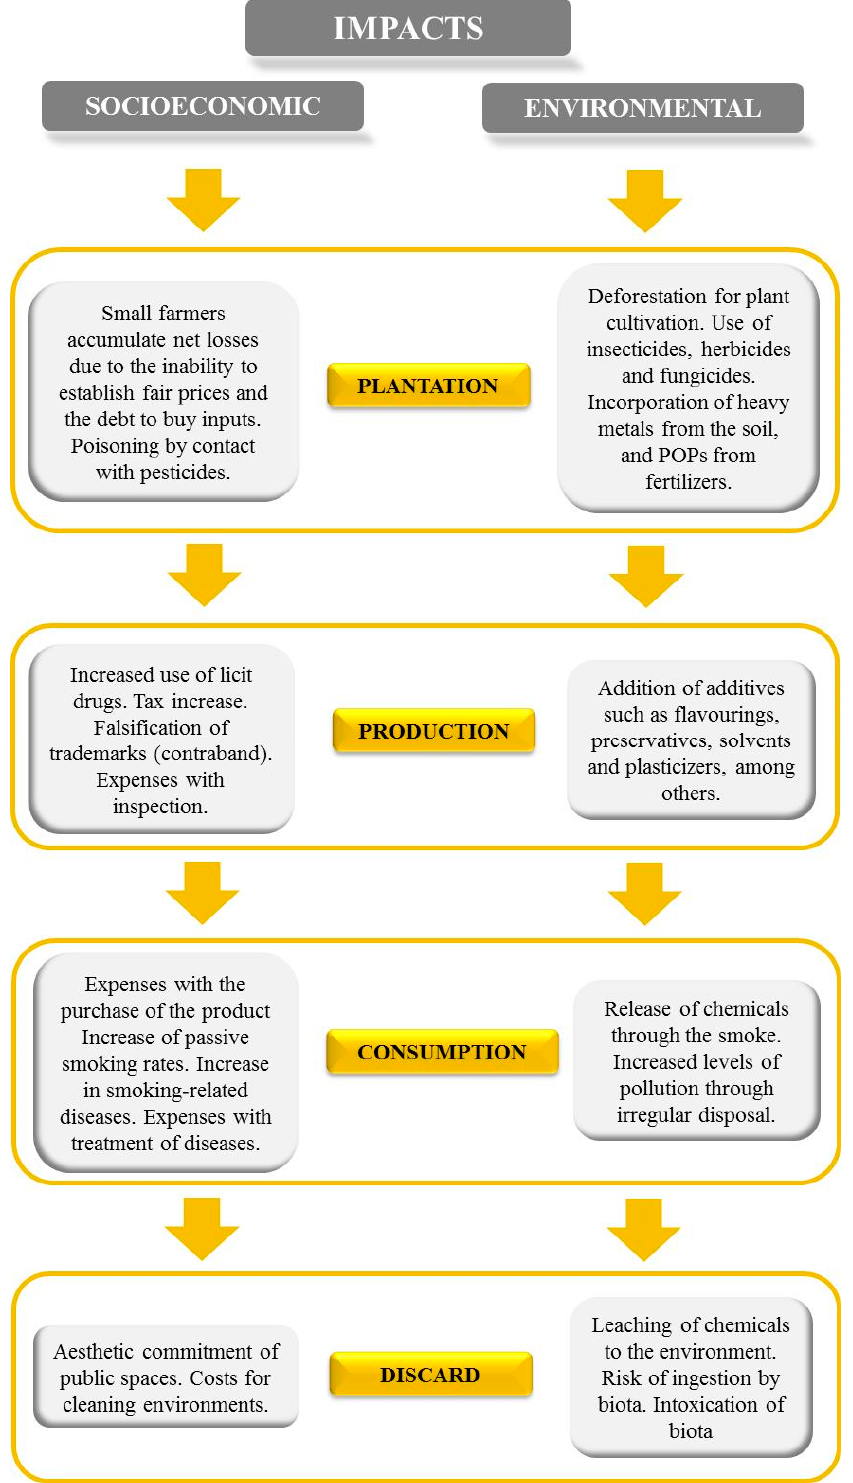
Figure 1. Socioeconomic and environmental impacts generated during the different phases of tobacco plantation, production, consumption (smoking) and the discarding of its wastes.